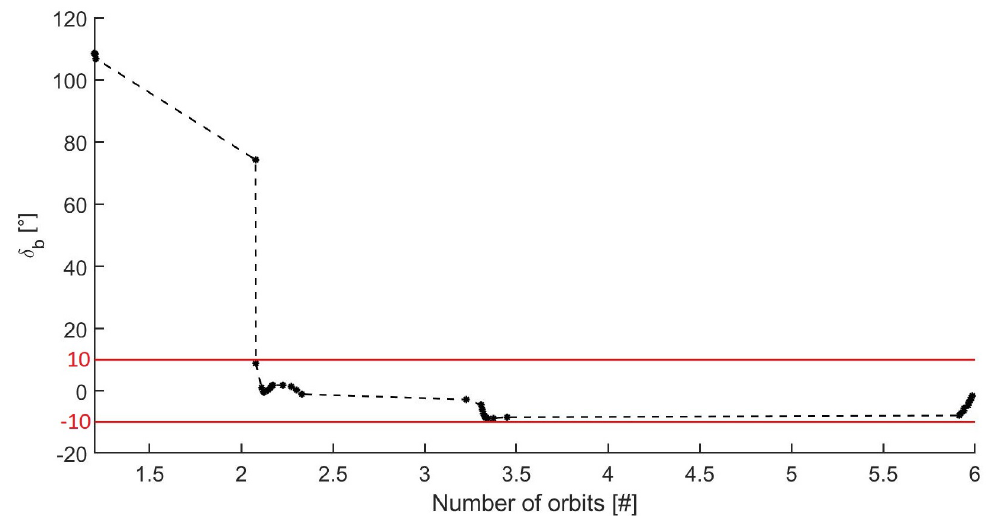
Figure 13. Misalignment error between ˆ z b and B b during the first orbits of ABCS: measured ( (cid:107) ) and fitted (dashed line)